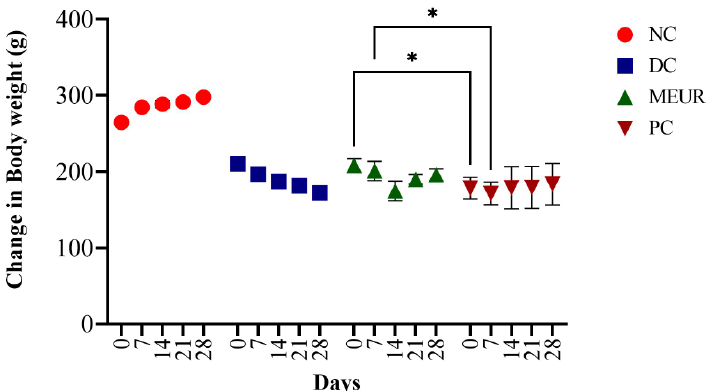
Table 1. Effect of MEUR on fasting blood glucose level. The effect of MEUR on fasting blood glucose levels of STZ-induced diabetic rats. Glibenclamide served as a positive control. Each value is ex- pressed as mean ± S.E.M. ( n = 6).